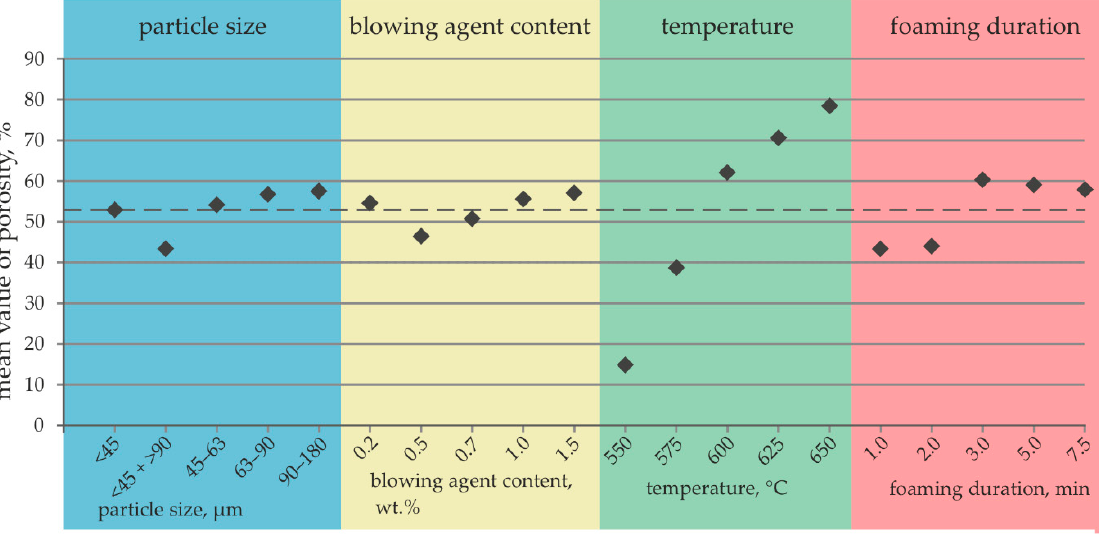
Figure 15. DoE evaluation of the effects of the investigated factors on the quality characteristic porosity.